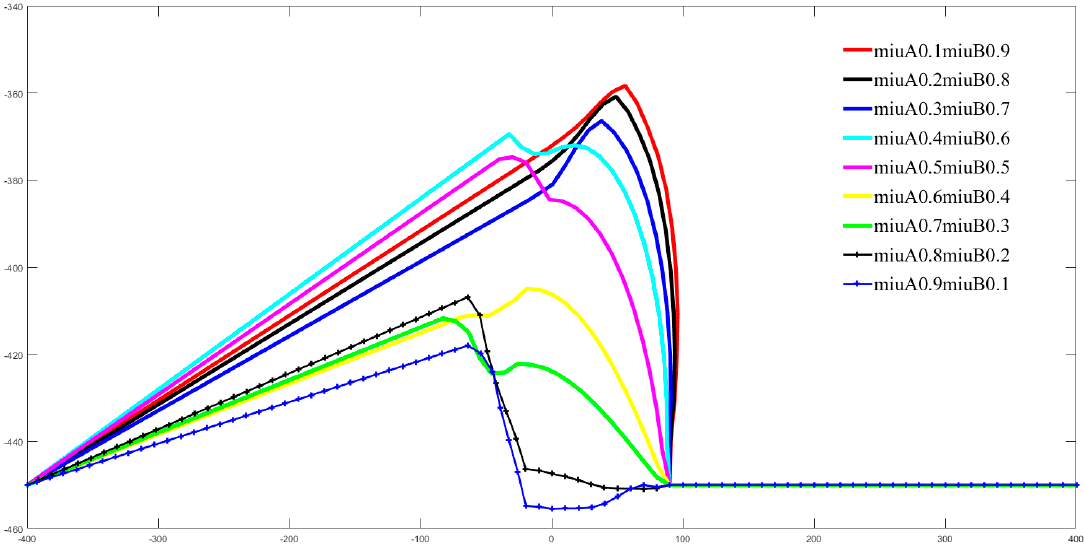
Figure 17. For Case 1 in Figure 13, the paths of the manipulator A EEF are simulated for different values of the positive circumventing weighting factors µ A and µ B .